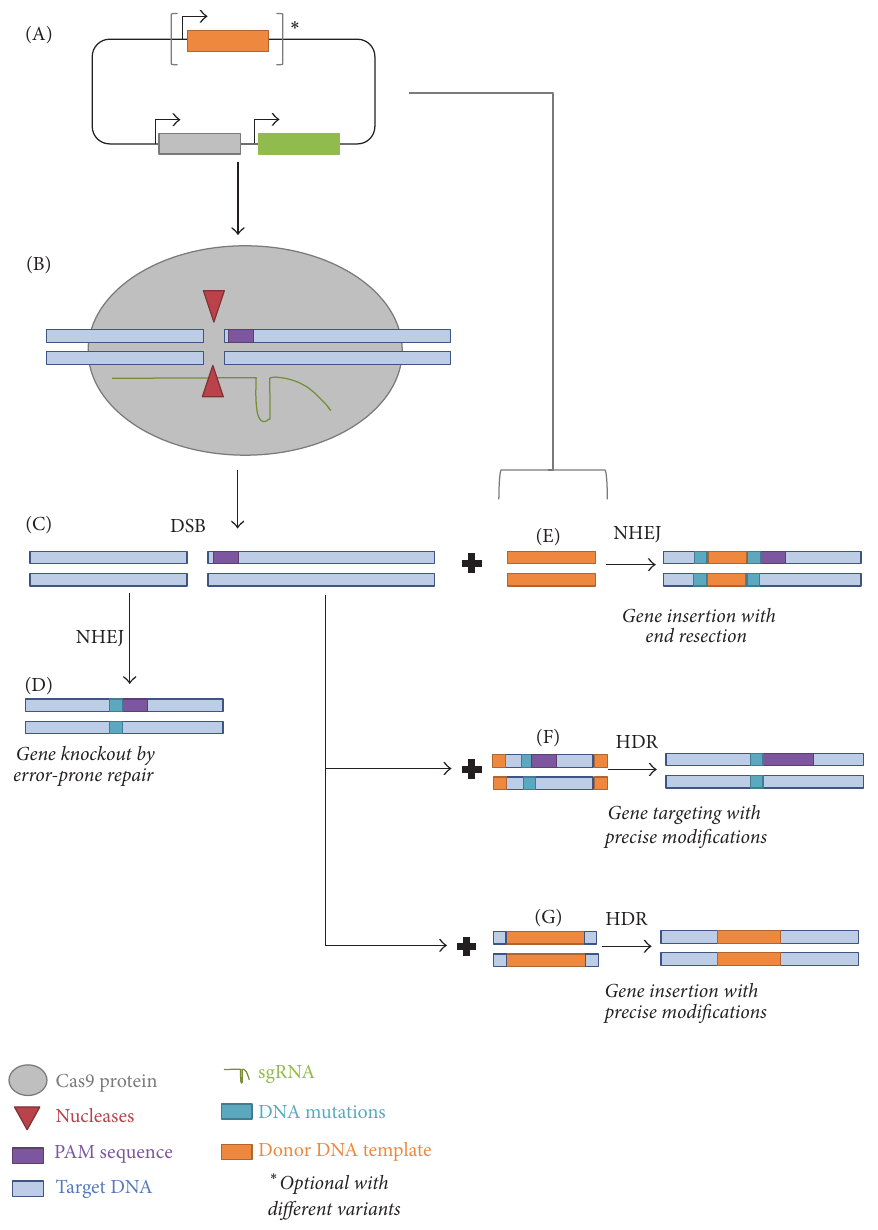
Figure1:OverviewofCRIPR-Cas9technologyforplantgenomeediting. (A)ThemostwidelyusedengineeredCRISPR-Cas9systeminplants utilizesaplant-codon-optimizedCas9proteinand(couldbemorethanone)single-guideRNA(sgRNA).Optionally,thegenetargetingsystem with geminivirus replicons includes an additional donor DNA template. (B) In plant cells, sgRNA associated with Cas9 nuclease mediates cleavage of target DNA sites that are complementary to the sgRNA and locate next to a PAM sequence. (C) Cas9-induced double-strand DNA breaks (DSBs) can be repaired by nonhomologous end-joining (NHEJ) or homology-directed repair (HDR) pathways. (D) Imprecise NHEJ-mediated repair can generate insertion and/or deletion mutations with variable length at the site of the DSB. These InDels can cause out-of-frame mutations in the coding sequences of the target genes, resulting in gene knockout. (E) In the presence of donor DNA, NHEJ can insert the donor DNA into the site of the DSB together with possibly additional InDel mutations. HR-driven repair can produce precise modifications, including point mutations (F) or insertions from double-/single-strand DNAs as donor templates